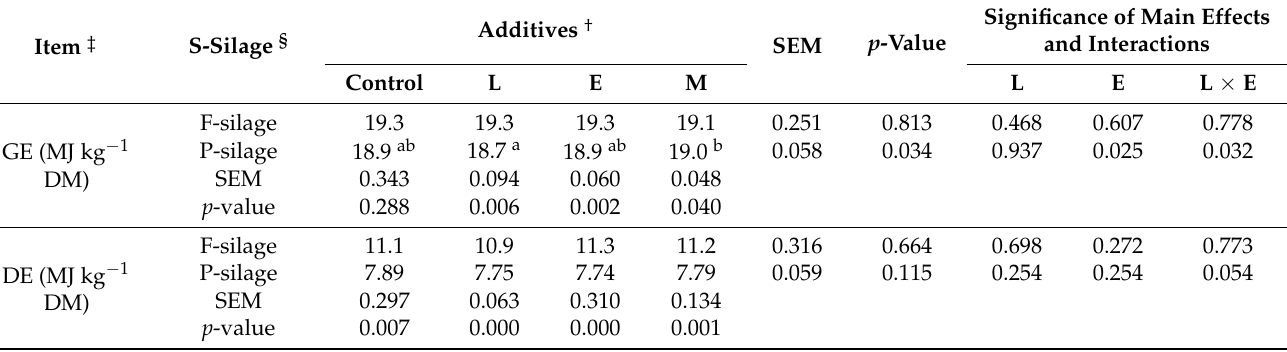
Table 5. Energy of spent mushroom substrate silages prepared with lactic acid bacteria and